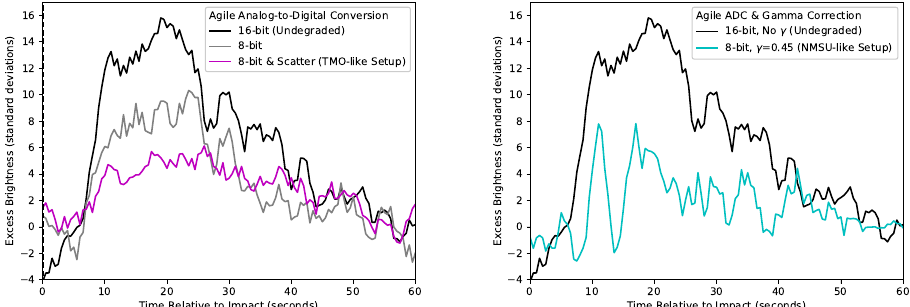
Figure 9. SNR retrieved for Agile data degraded with 8-bit resolution ( left ) and both 8-bit resolution and gamma correction ( right ) at the maximum SNR pixel (see Figure 4). The TMO-like setup (magenta line) shows the possibility of a visible-band plume detection with an observational setup similar to that of TMO. TMO, however, did not achieve a high SNR of the illuminated lunar landscape before the ADC process, unlike the degraded Agile data here. Thus, the magenta line ought to have a greater SNR than any plume signal in the TMO data. The cyan line in the right panel is degraded to 8-bit resolution with gamma correction of 0.45 and the dynamic range adjusted to match that of the NMSU